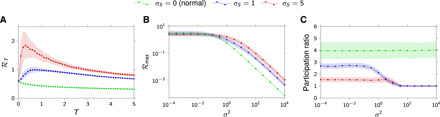
Role of non-normality in high-dimensional, heterogeneous networks.(A) Information rate as function of the transmission window T for n = 20, σ2 = 1, B = C = I, and A drawn according to Eq. 12. (B) Maximum information rate ℛmax = maxT≥0 ℛT as a function of the readout noise variance σ2. (C) Effective dimensionality [quantified using the “participation ratio”; see (46) and Materials and Methods] of the input distribution that defines the optimal allocation of input power as a function of the output noise variance σ2. In all panels, colors indicate the degree of non-normality (σs) of the network. Light-colored regions denote 95% confidence interval (CI) around the mean, estimated from 50 independent realizations of the 20 × 20 random matrix A, drawn according to Eq. 12.